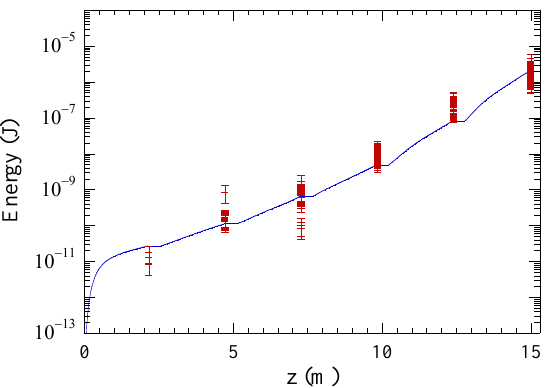
Figure 2. Simulated (blue line) and measured (red crosses) pulse energy as a function of the propaga- tion distance z for the SPARC experiment. The different points correspond to individual measure- ments and the error bar indicates the error in each of the measurements. The simulation result is an average over 20 noise realizations.